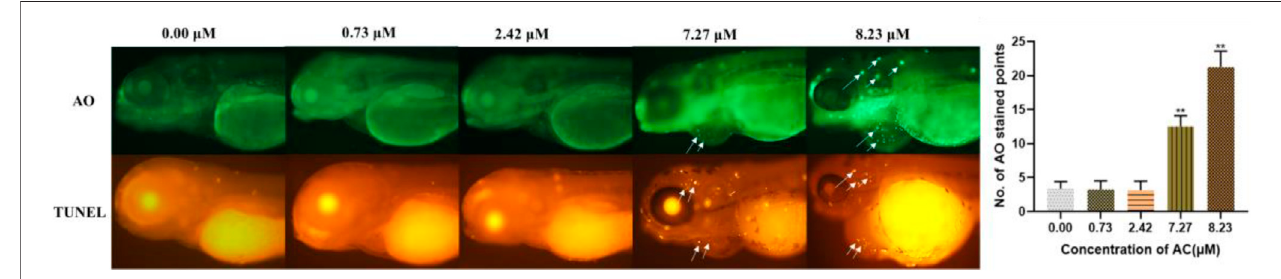
FIGURE6| AC-induced apoptosis in96 hpf zebra fi shembryo. AOand TUNEL stainingofthe apoptotic cells(white arrows indicate apoptotic cells inthe brainand heart).